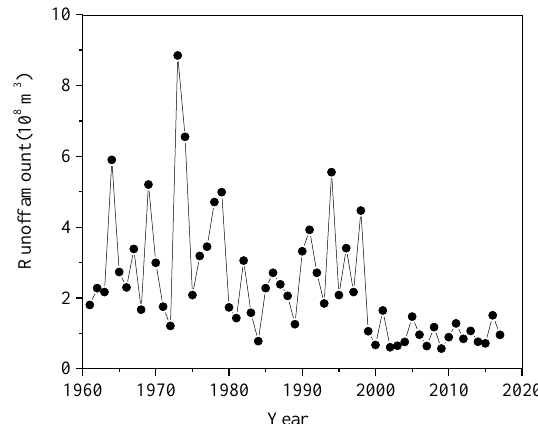
Figure 7. Annual water inflow into the Miyun Reservoir from the Chaohe River (data from Hydrological Data of Haihe River Basin, Annual Hydrological Report).